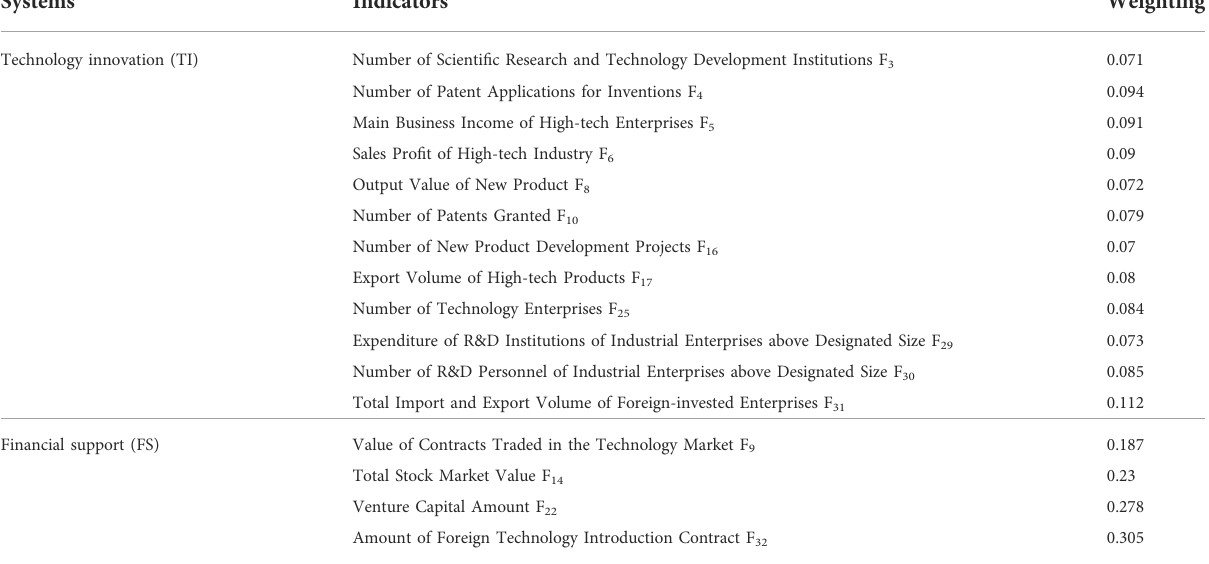
TABLE 1 Adaptation relationships and weights of subsystems and underlying indicators.